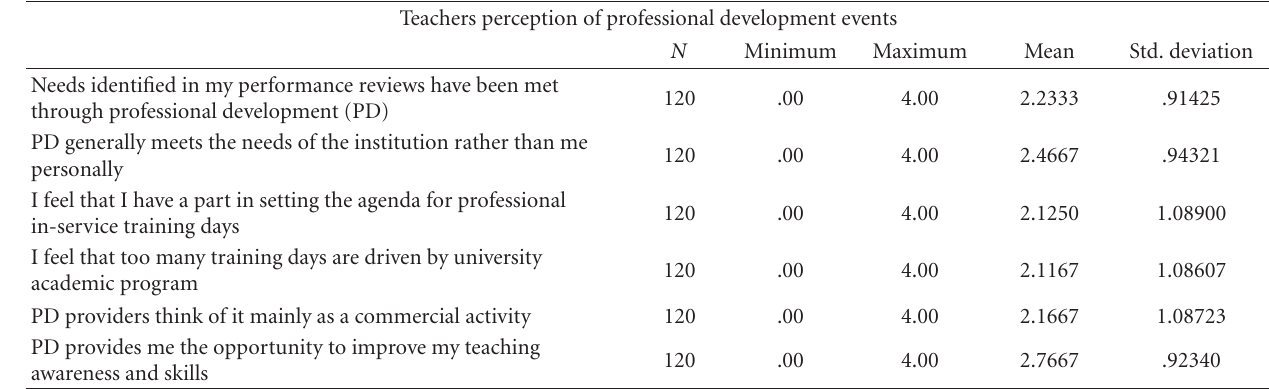
Table 4: Teachers perceptions on the implementation of PDP.